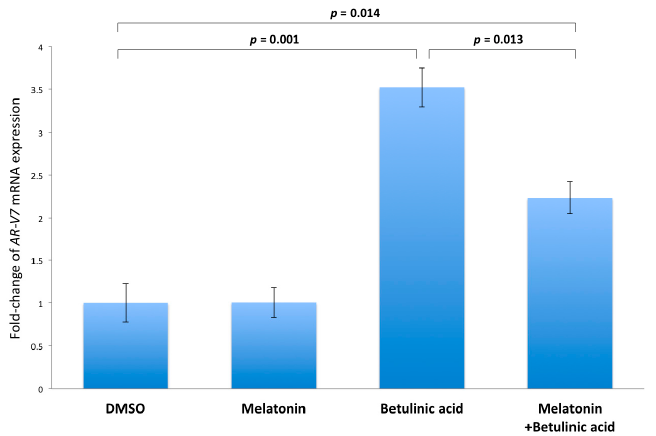
Figure 6. Q-PCR analysis of androgen receptor splice variant-7 ( AR-V7) mRNA expression. LNCaP cells were treated with 10 − 6 M melatonin, 10 − 6 M betulinic acid, 10 − 6 M melatonin plus 10 − 6 M betulinic acid, or 0.001% dimethylsulfoxide (DMSO) for 48 h. The relative levels of AR-V7 were then measured by Q-PCR and were compared to cells treated with DMSO as a control. Data are shown as relative fold-change of AR-V7 mRNA expression ± S.E.